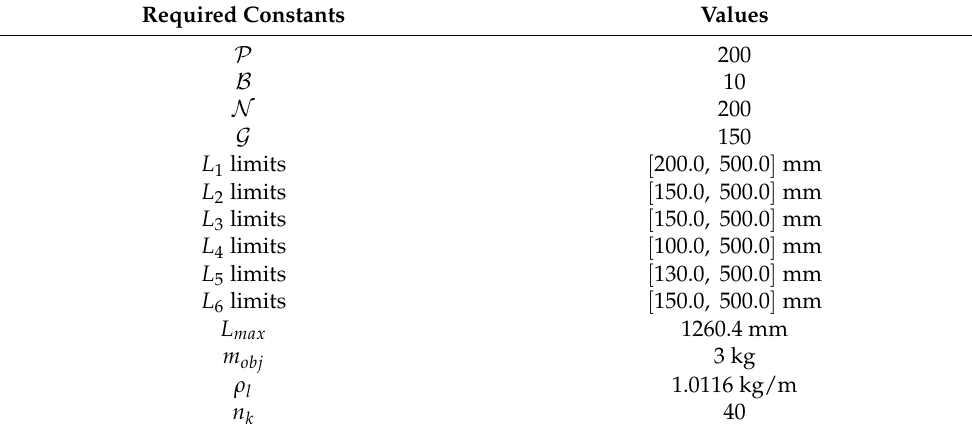
Table 4. Optimization parameters.